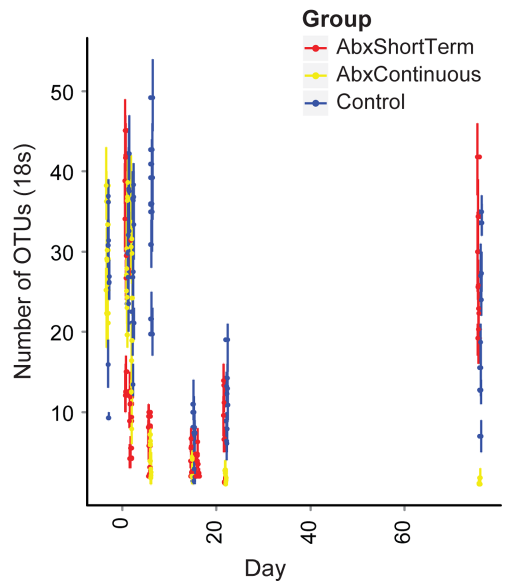
Figure 7. Abundance analysis of observed fungal lineages. Each sequence set was rarefied to 200 sequences per sample, and the number of different OTUs assessed. Means are indicated by points, error bars indicate the range observed. The groups studied are indicated by the key at the right.